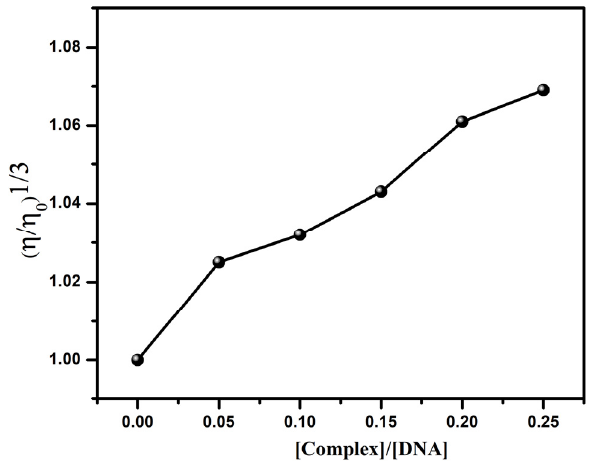
Figure 6. Relative viscosity ( η / η 0 ) 1/3 of ctDNA solution (30 μ M) in the presence of complex 1 at var- ying amounts (r) at 25 °C; r = [Complex 1]/[DNA]; 0.0, 0.05, 0.1, 0.15, 0.2, 0.25).